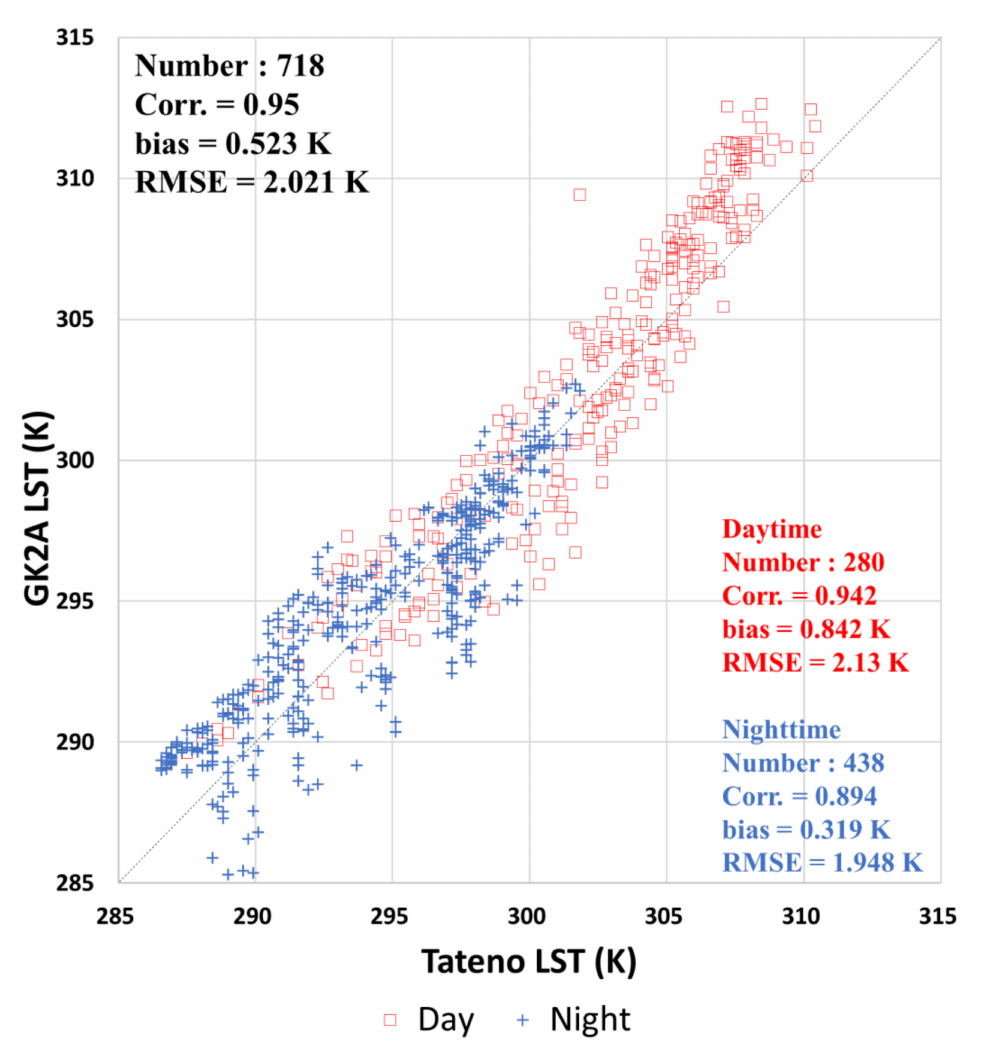
Figure 11. Scatter plot between the GK2A LST and the LST at Tateno station from upward longwave radiation (red square symbol: daytime, blue cross symbol: nighttime, gray dotted line represents the 1:1